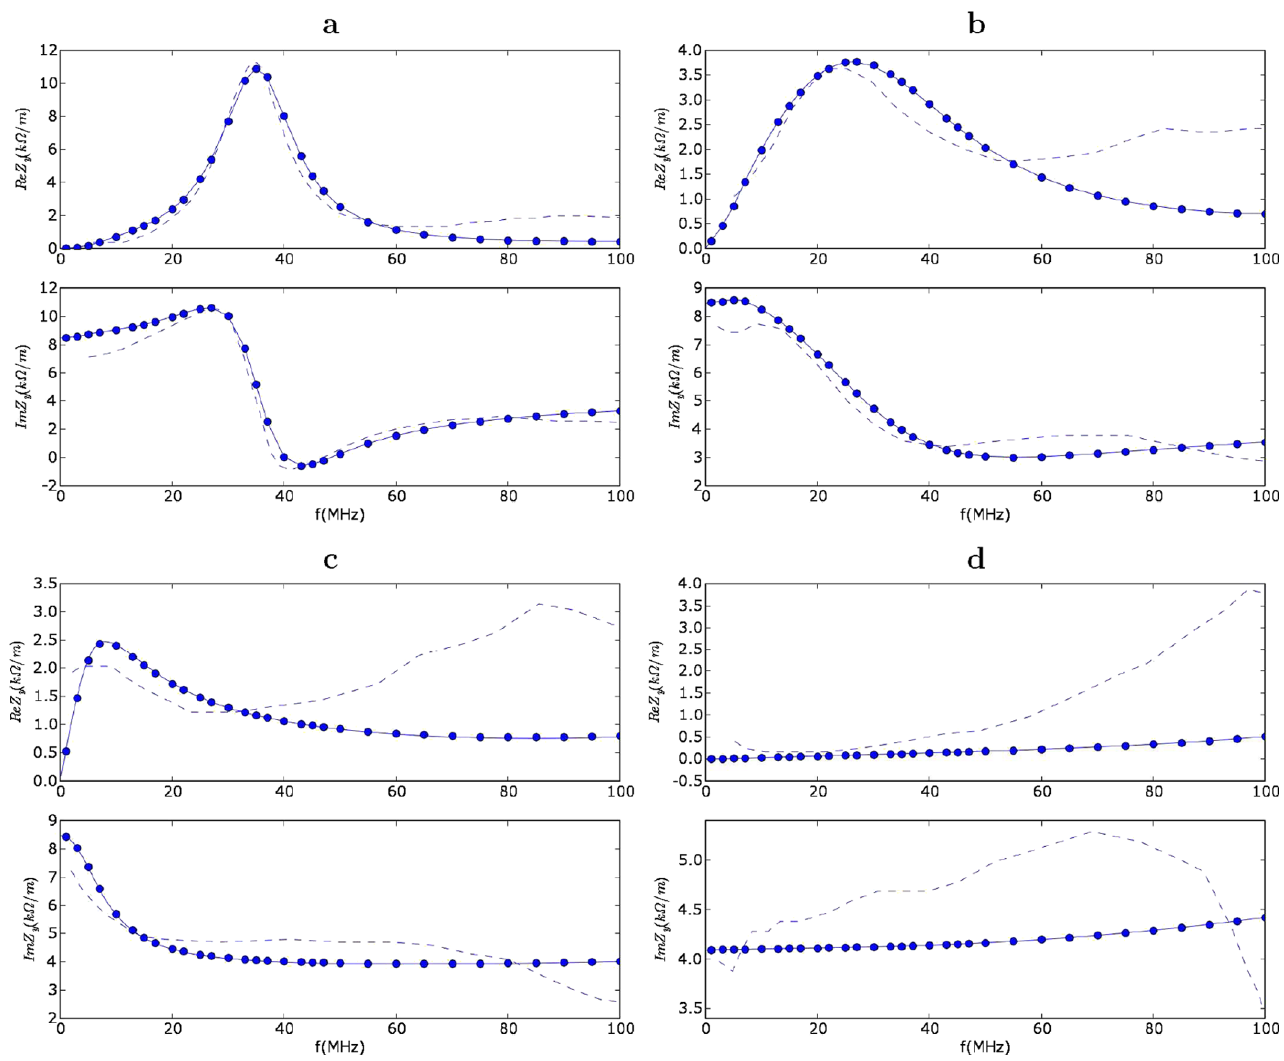
(cid:6) 1 (a), 200 (cid:2) (b), 50 (cid:2) (c), and 0 (cid:2) (d). Experimental FIG. 4. (Color) Real and imaginary part of Z vs frequency for the cases Z y g (cid:1) ! (cid:2) , dots] and estimation measurements (dashed lines) [[3] (Fig. 5) and [23] (Fig. 4)] results from numerical field simulations [ Z sim y (cid:1) ! (cid:2) , solid lines], Eq. (15), are plotted together for from the parametrization [ Z model y